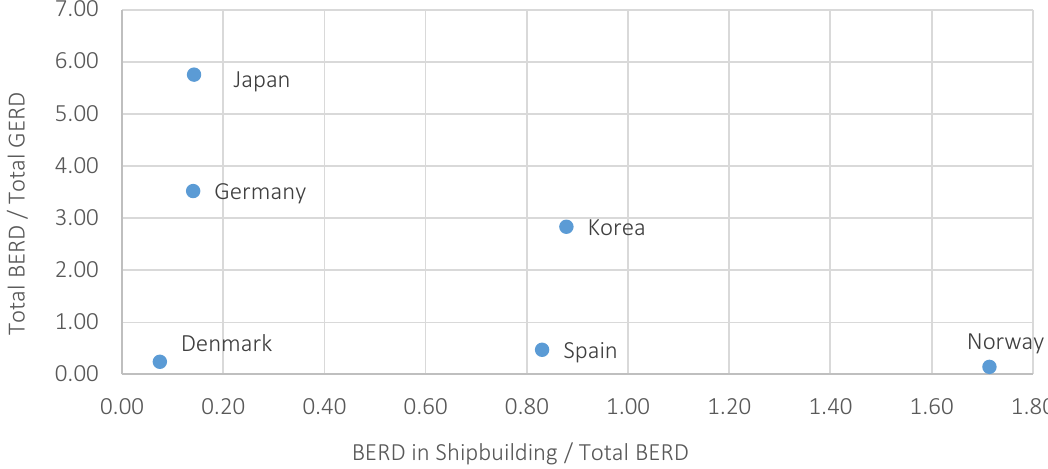
Figure 4. Relation between BERD as a proportion of GERD and BERD in Shipbuilding industry as a proportion of total BERD